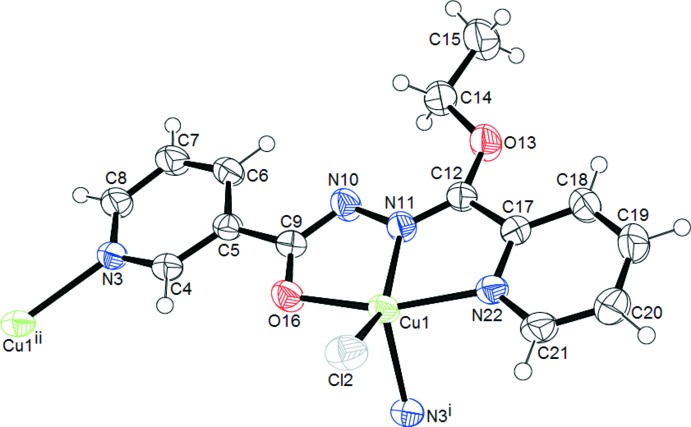
An ORTEP view of the repeat unit of the coordination polymer I, showing the atom-numbering scheme. Displacement ellipsoids are drawn at the 50% probability level. Symmetry codes: (i)  − x, − + y,  − z; (ii)  − x,  + y,  − z.